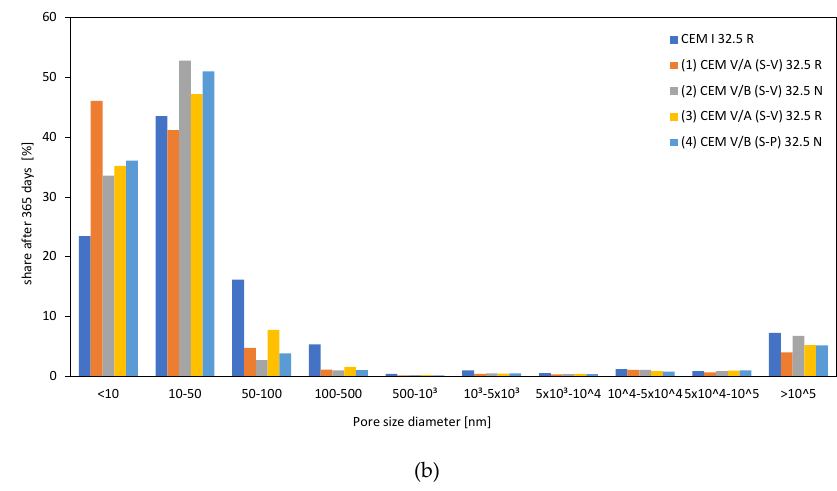
Figure 7. Comparison of pore-size distribution after 28 ( a ) and 365 days ( b ) curing time.